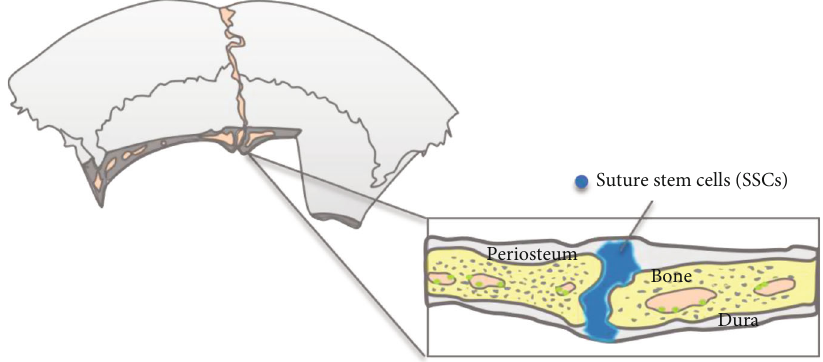
Figure 3: Stem cell distribution in